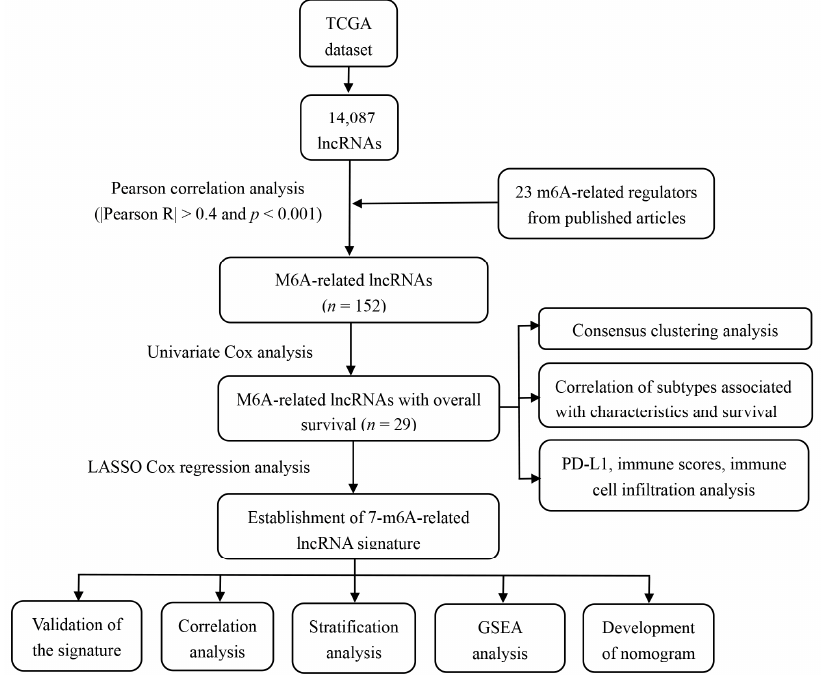
Figure 1. The entire analytical process of the